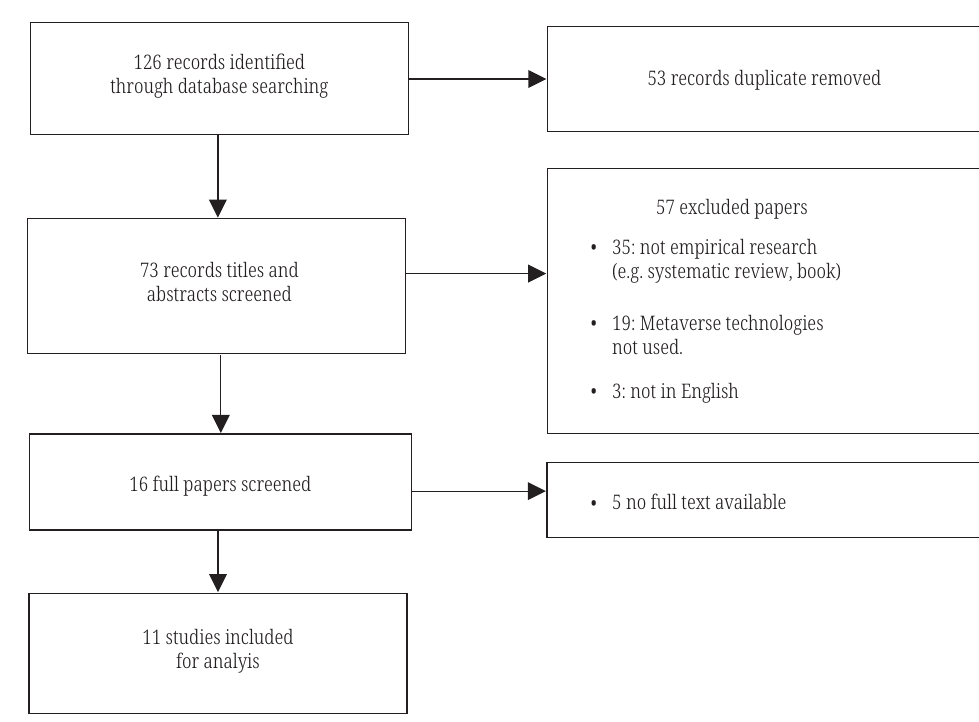
Fig. 2. PRISMA flowchart adapted from Brunton et al.